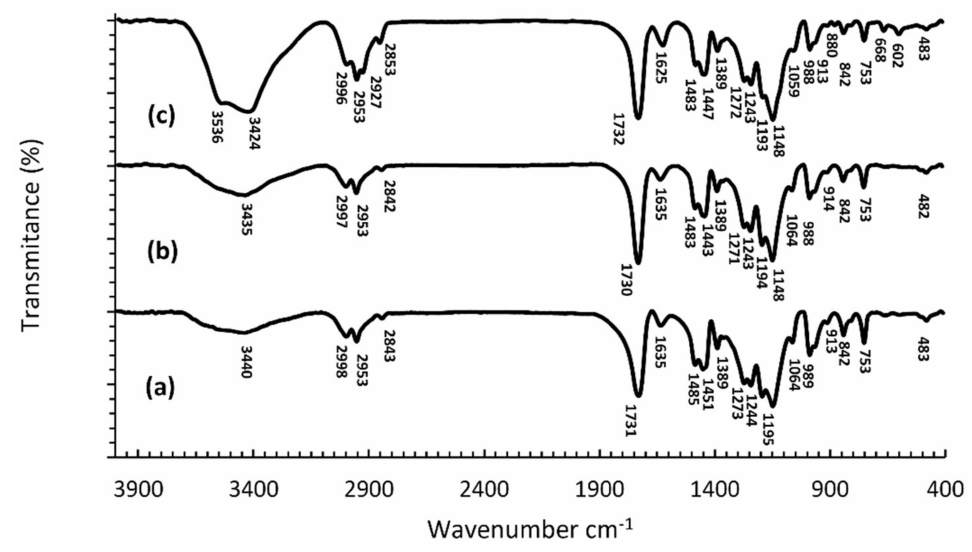
Figure 4. FTIR spectra of the polymerized heat-curing PMMA ( a ), the polymerized heat-curing 10% AgNPs PMMA ( b ), and the polymerized heat-curing 10% AgCl PMMA ( c